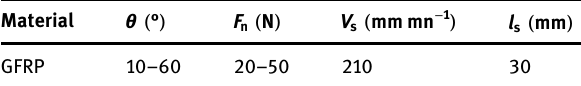
Table 1: Experimental parameters considered for a scratch test